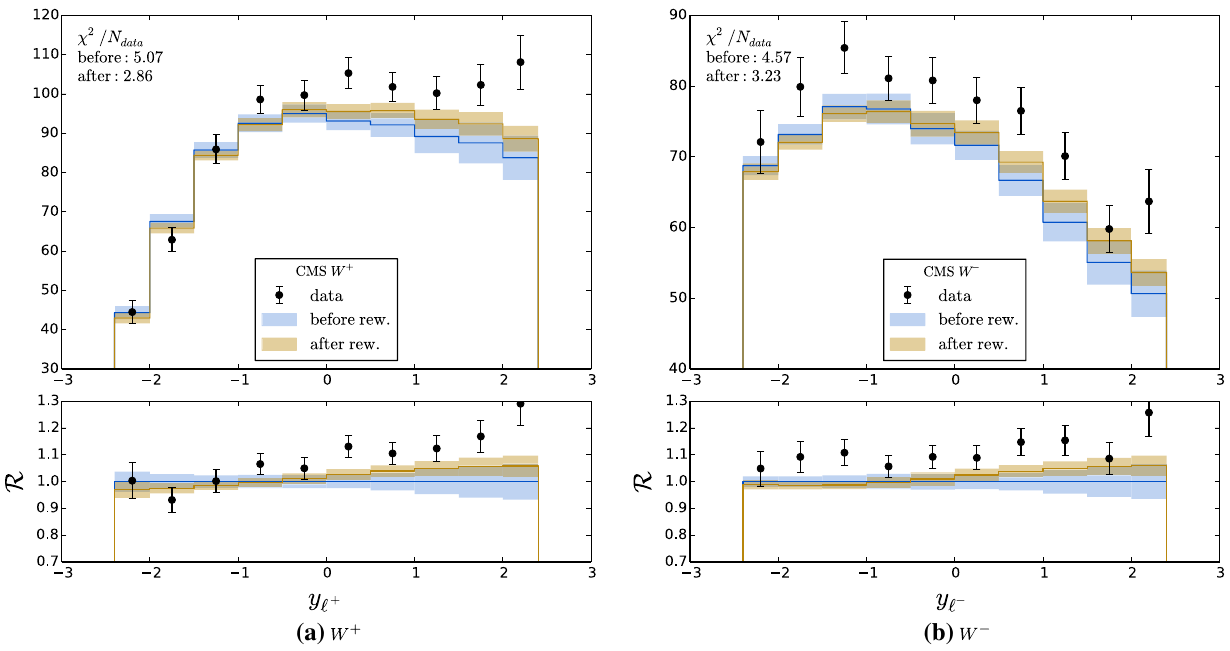
Fig. 25 Comparison of data and theory before and after the reweighting procedure using all LHC pPb data. The results for the CMS W + ( left ) and W − ( right ) distributions are shown